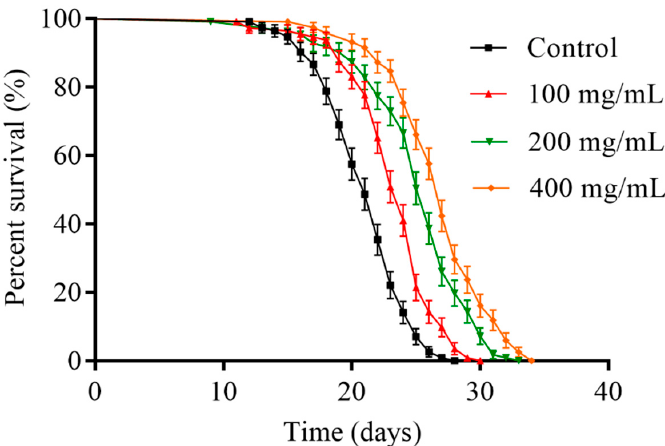
Figure 2. E ff ect of orange extracts on the lifespan of N2 wild-type C. elegans . Day 1 adult nematodes at the L4 stage (fourth larval stages) were treated with and without orange extracts (0, 100, 200, or 400 mg / mL) at 20 ◦ C. The survival was counted starting from day 1 of adulthood to death. Supplementation treated with orange extracts (control). The experiment was performed in triplicate. Table 1. E ff ect of orange extracts on thee lifespan of N2 wild-type C. elegans (mean ± SD, n =